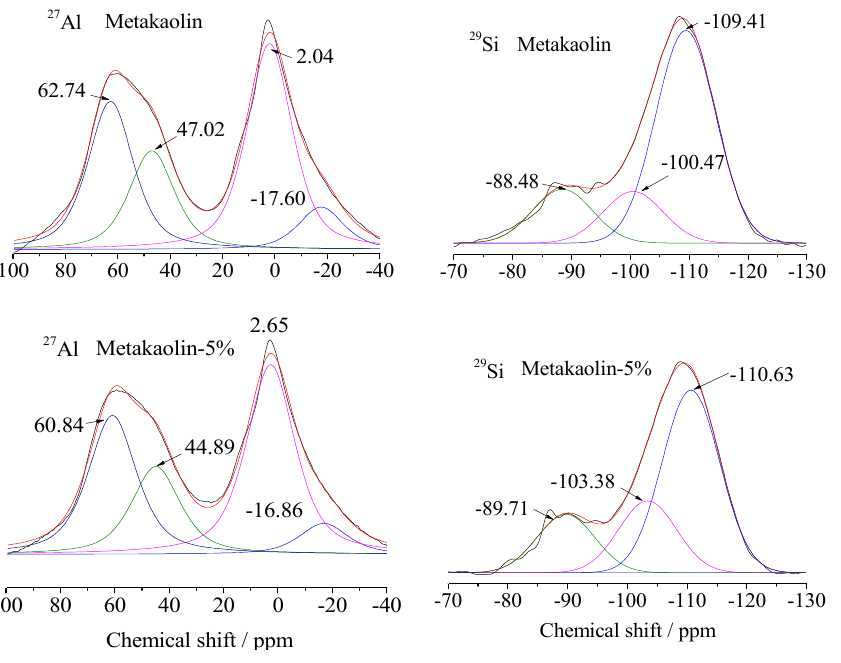
Figure 5. The 27 Al and 29 Si MAS-NMR spectra of metakaolin and metakaolin-5%. Another two peaks at − 17.60 ppm and − 16.68 ppm in the 27 Al MAS-NMR spectra of calcined kaolin and calcined kaolin-5%, respectively, can possibly be assigned to Al V [23].